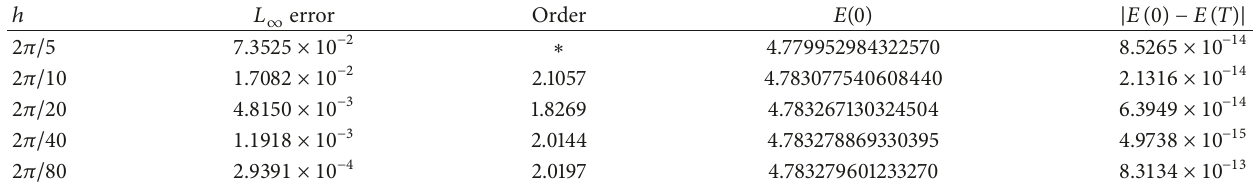
Table 1: Energy error and space convergence orders by the scheme proposed in this paper with 𝜏 = 0.001 and several values of ℎ for 𝑇 = 1 . ℎ 𝐿 ∞ error